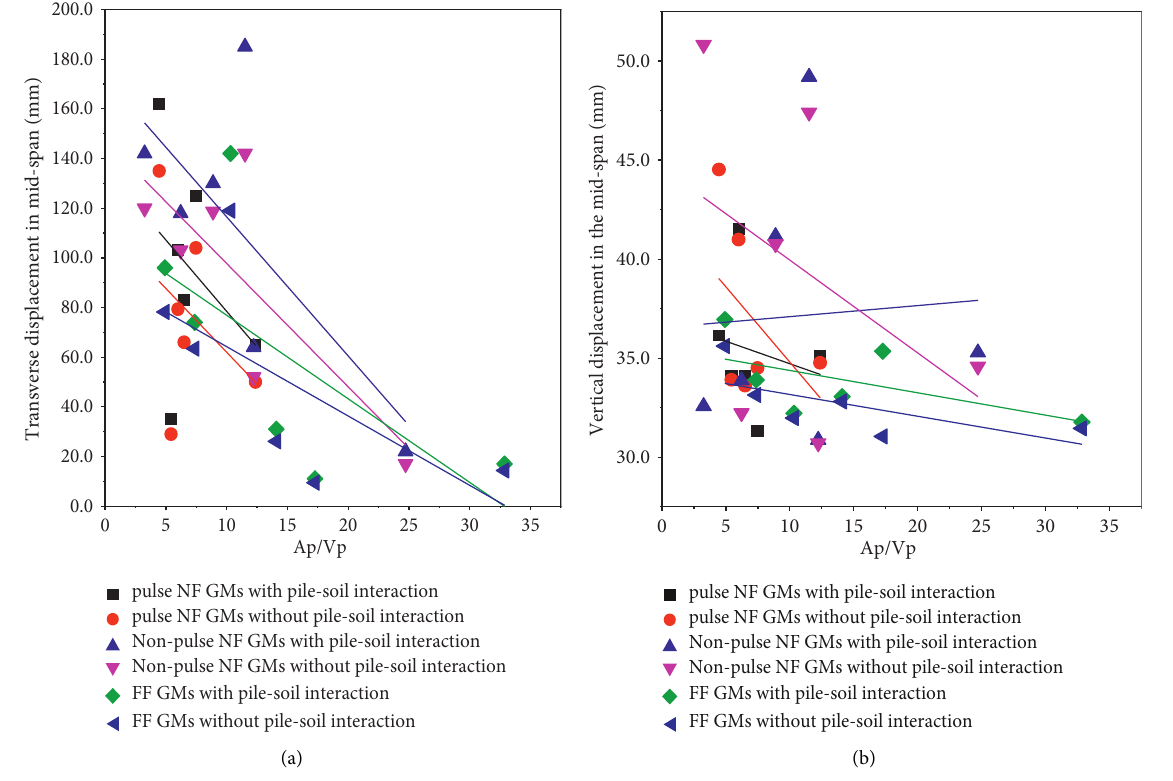
Figure 4: A P / V P values and seismic dynamic response. (a) Transverse displacement in the beam span. (b) Vertical displacement in the beam span.